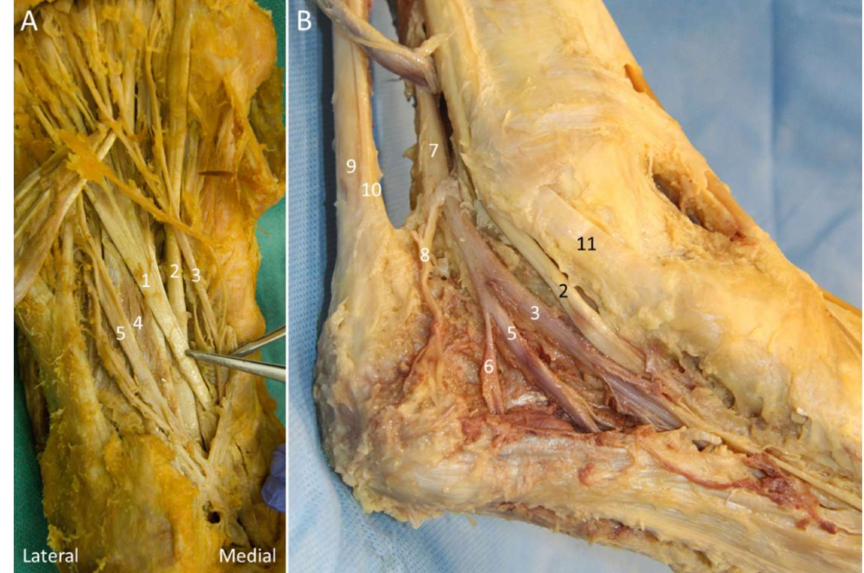
Figure 24. Cadaveric models for demonstrating the knot of Henry ( A ) and Baxter nerve ( B ). 1: Flexor digitorum longus tendon; 2: flexor hallucis longus tendon; 3: medial plantar nerve; 4: quadratus plantae muscle; 5: lateral plantar nerve; 6: Baxter nerve; 7: tibial nerve; 8: medial calcaneal nerve; 9: Achilles tendon; 10: plantaris tendon; 11: tibialis posterior